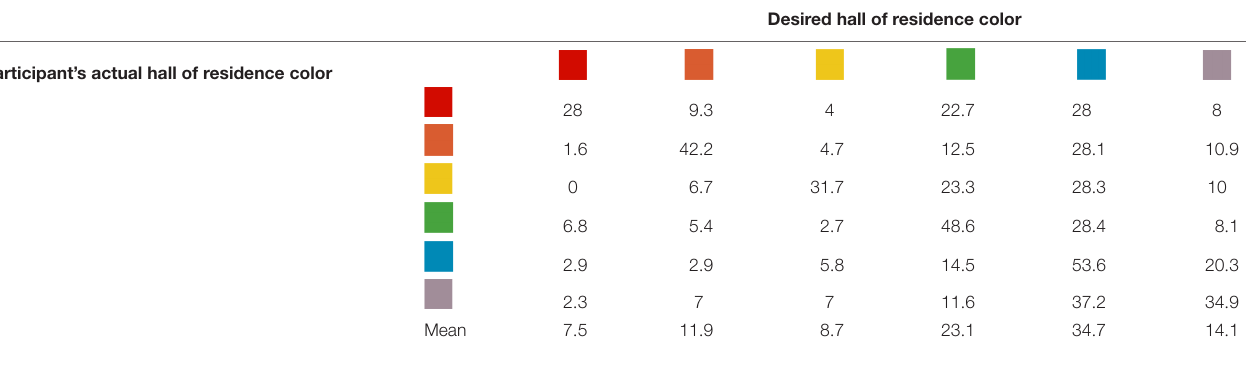
Desired hall of residence